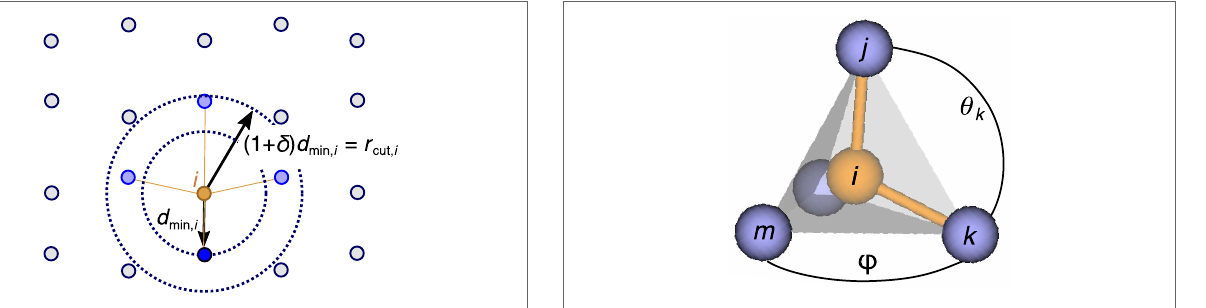
FIGURE 3 | Definition of atom indices, i , j , k , and m , as well as angles, θ (polar) and φ (azimuth), which are used in the computation of the order parameters introduced by Peters (2009) and Zimmermann et al.